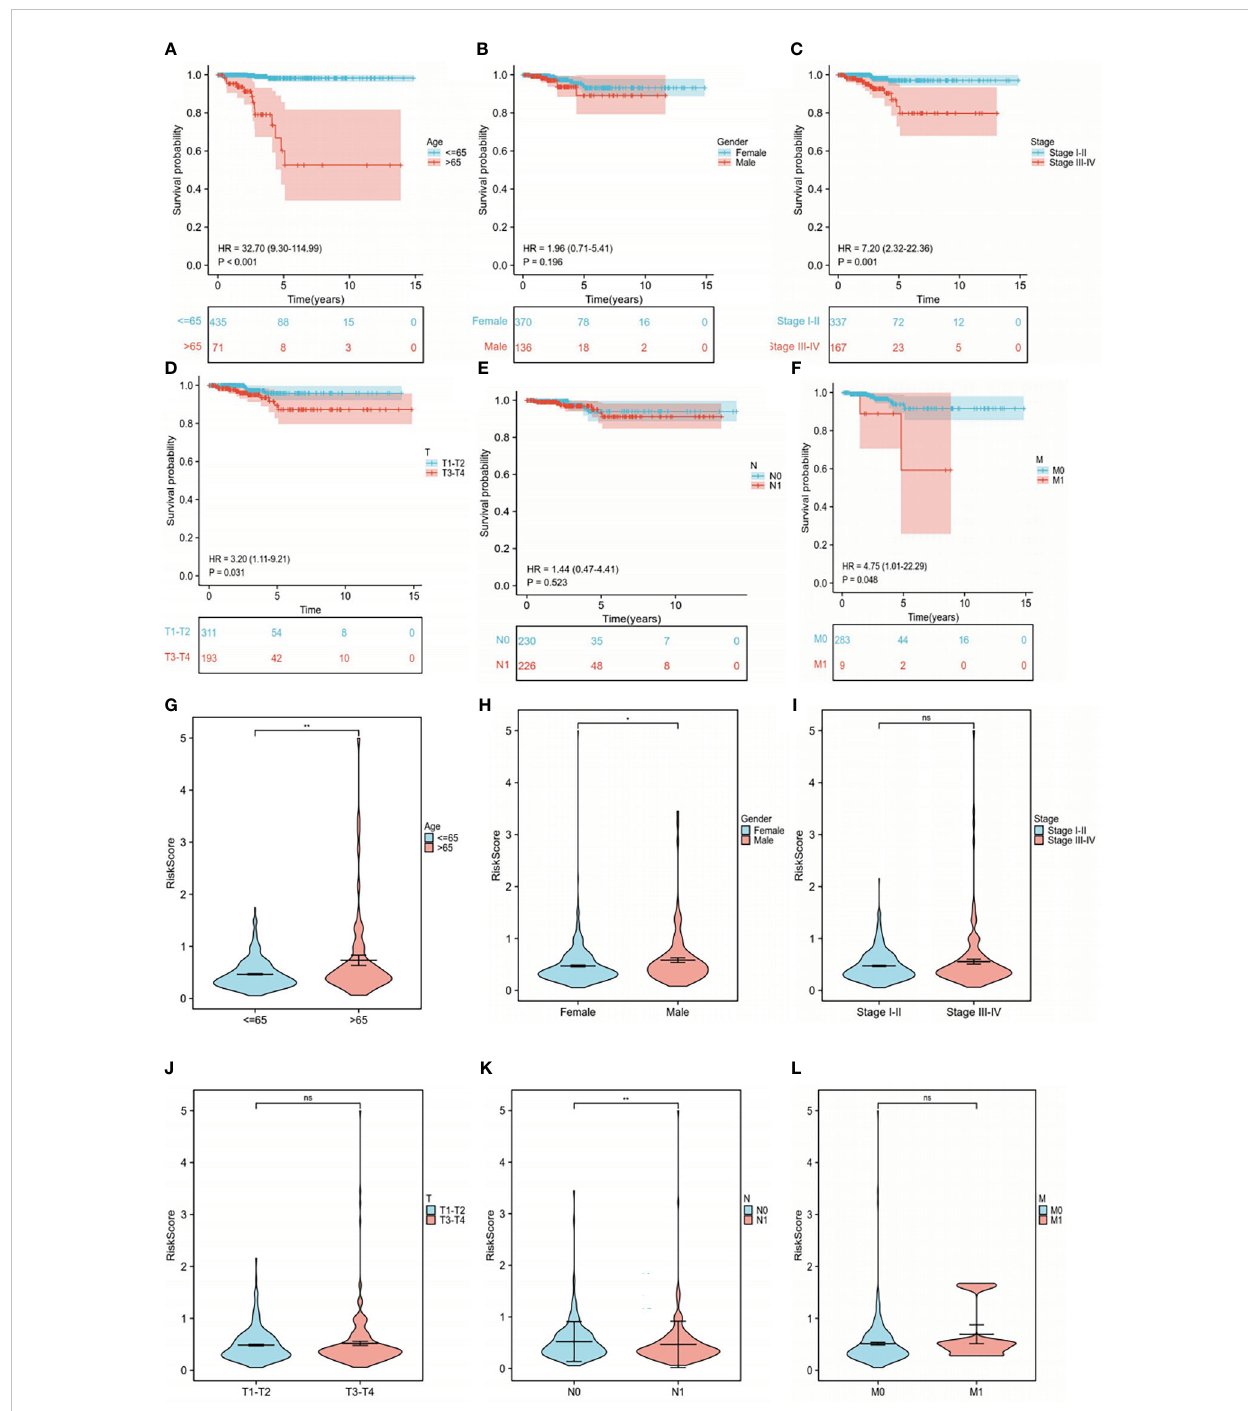
FIGURE 7 Subgroup clinical trait analysis. (A-F) Association of each clinical trait (age, gender, stage, TNM stage) with survival probability. (G-L) Association of each clinical trait (age, gender, stage, TNM stage) with risk score. "ns" means “ no signi fi cance ” *P<0.05, **P<0.01, P<0.05 was considered signi fi